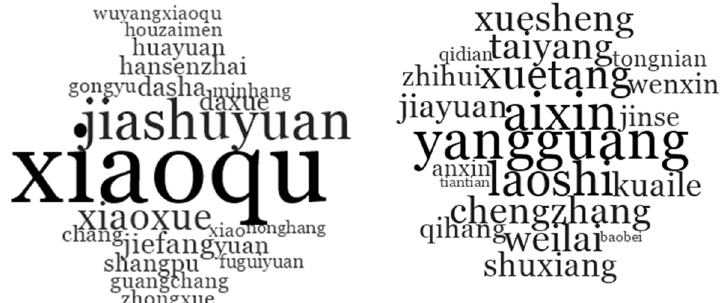
Fig. 1 Words clouds of “address” and “name” of out-of-school hours care places